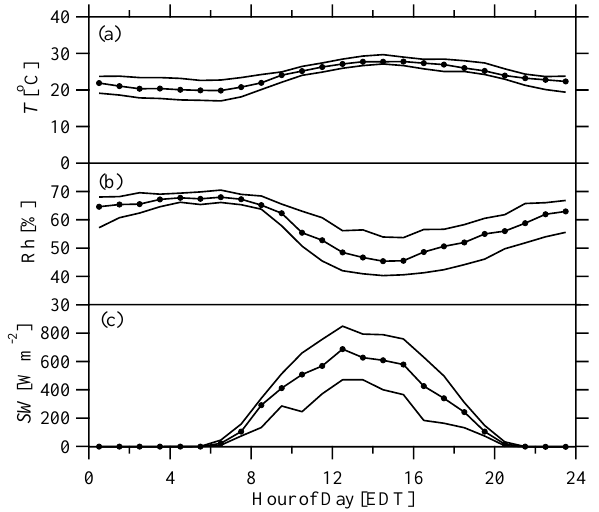
Figure 1. Hourly median and quartiles of (a) temperature, T , (b) relative humidity, RH, and (c) incoming solar radiation, SW, all at a height of 33m, for the 22 days of the